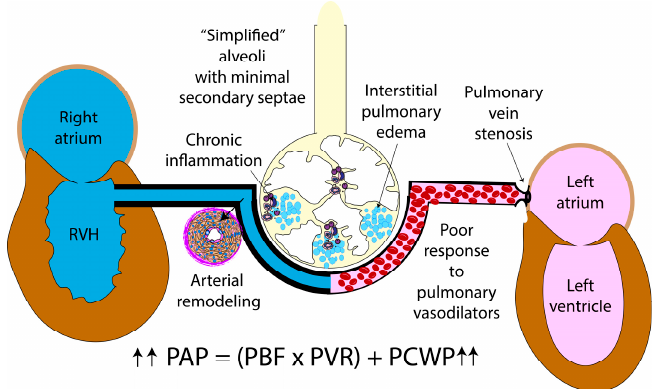
Figure 4. Hemodynamics in pulmonary vein stenosis. Pulmonary venous congestion results in interstitial edema leading to poor response to pulmonary vasodilators. Elevation of pulmonary capillary wedge pressure (PCWP) leads to elevated pulmonary arterial pressure (PAP). Further alterations in pulmonary blood flow (PBF), as seen in left-to-right shunts, or changes in pulmonary vascular resistance with BPD and chronic PH can further elevate PAP. Copyright Satyan Lakshmin- rusimha.